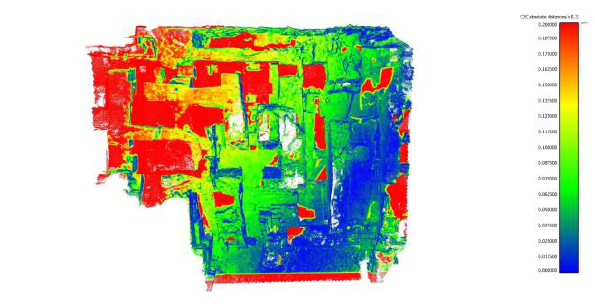
Figure 7. Comparison between the laser scanner point cloud and the GoPro point cloud built in Metashape